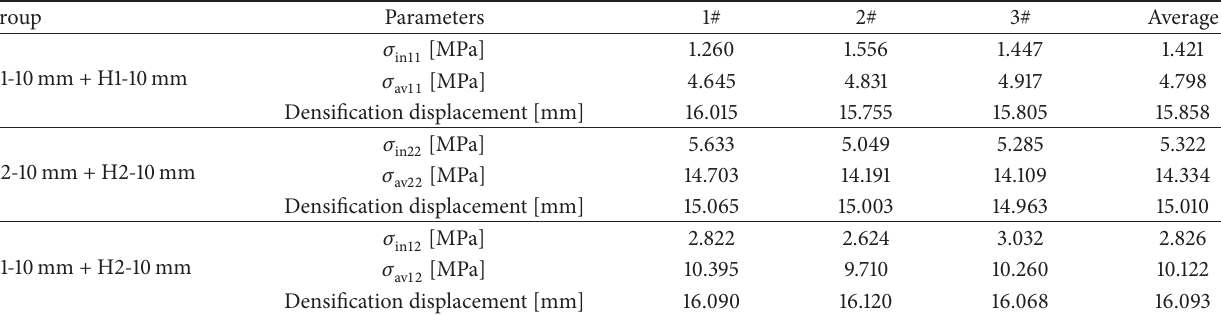
Figure 5: Typical compressive deformation of two stack-up CHAH samples (H1-10mm + H1-10mm) in the axial direction. (a) 𝑆 = 0 mm, (b) 𝑆 = 5 mm, (c) 𝑆 = 10 mm, and (d) 𝑆 = 15 mm. Table 2: Compressive parameters of two stack-up